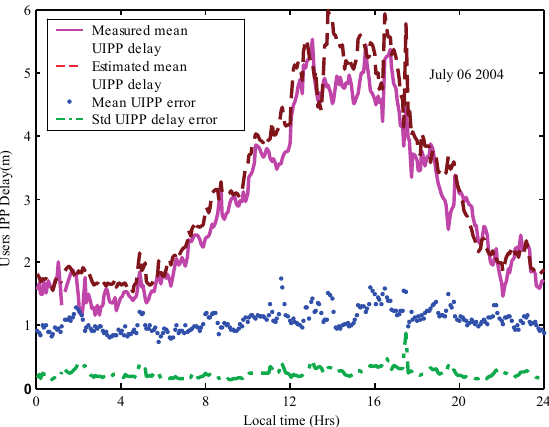
Fig. 2. Estimated mean UIPP delay and mean UIPP delay error using bilinear interpolation technique (6 July 2004)